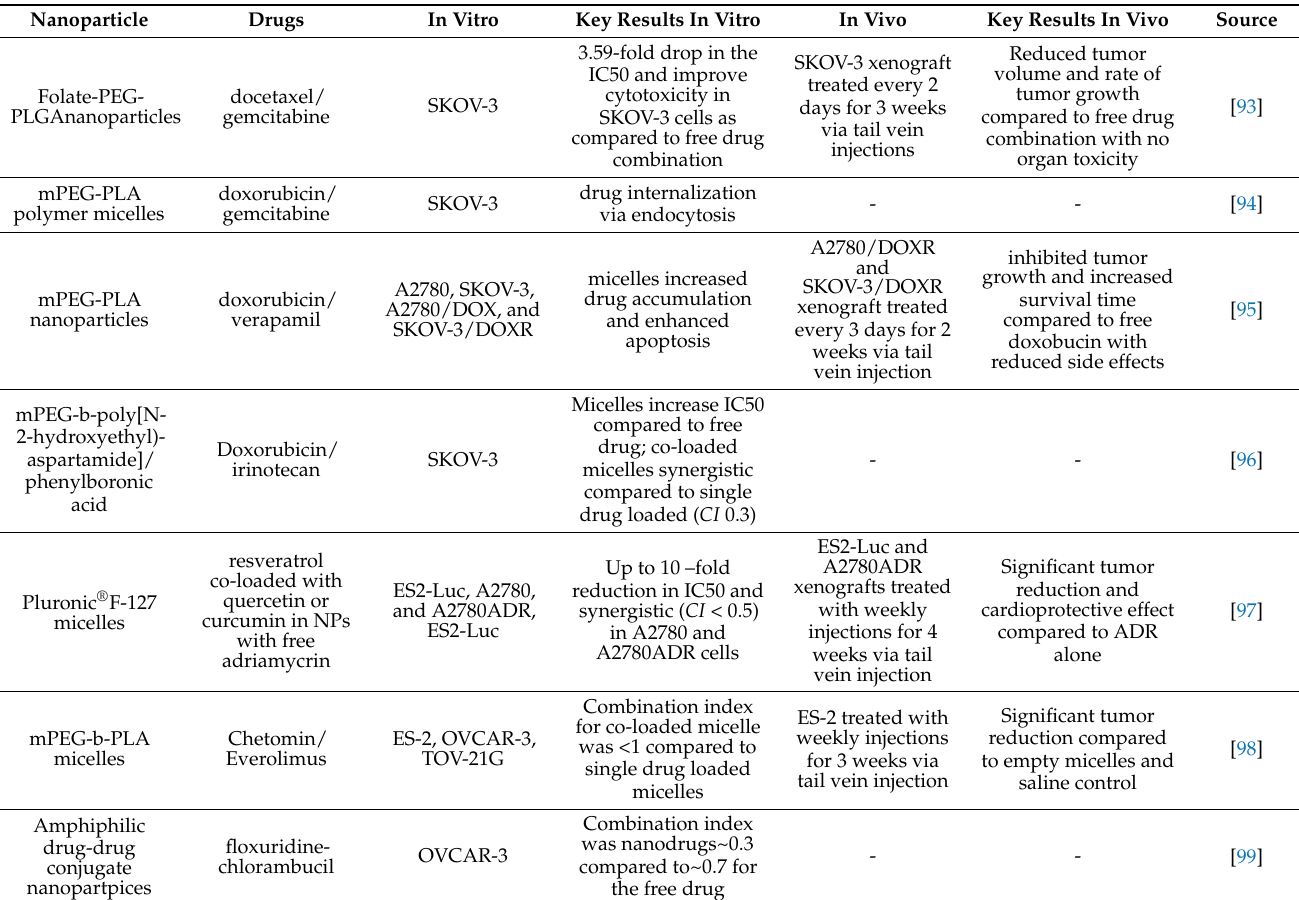
Table 3. Formulations of other drug combinations using polymer